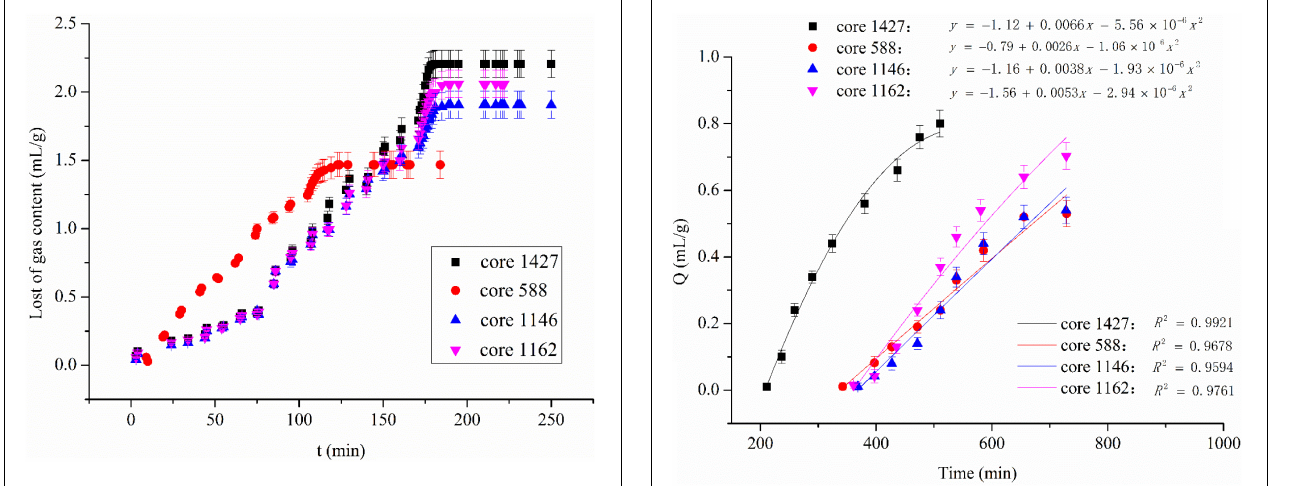
FIGURE 12 | The loss of gas volume in shale obtained by the curve fitting method.